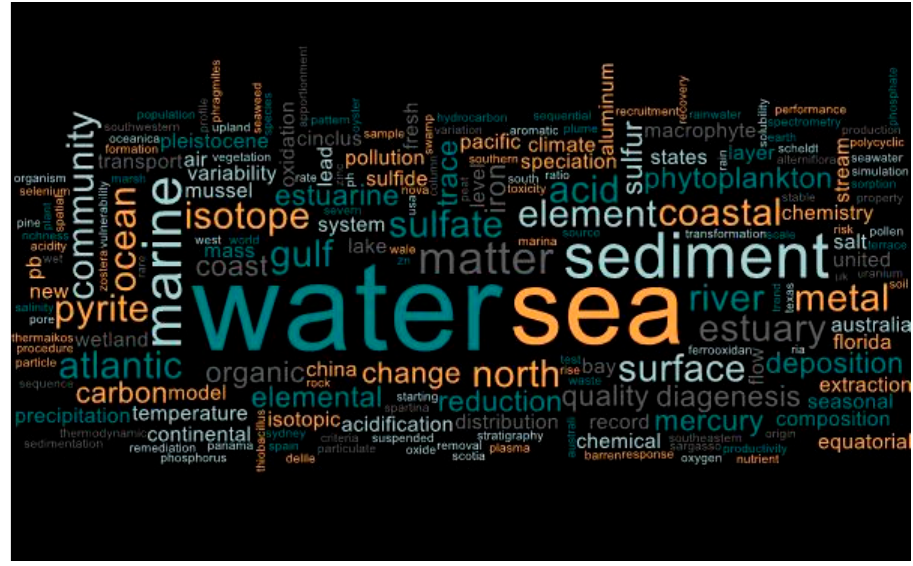
Figure 9. The most cited keywords in publications related to the impacts of climate change on heavy metal contamination in coastal areas, based on the Web of Science Core Collection database (1979– 2021).